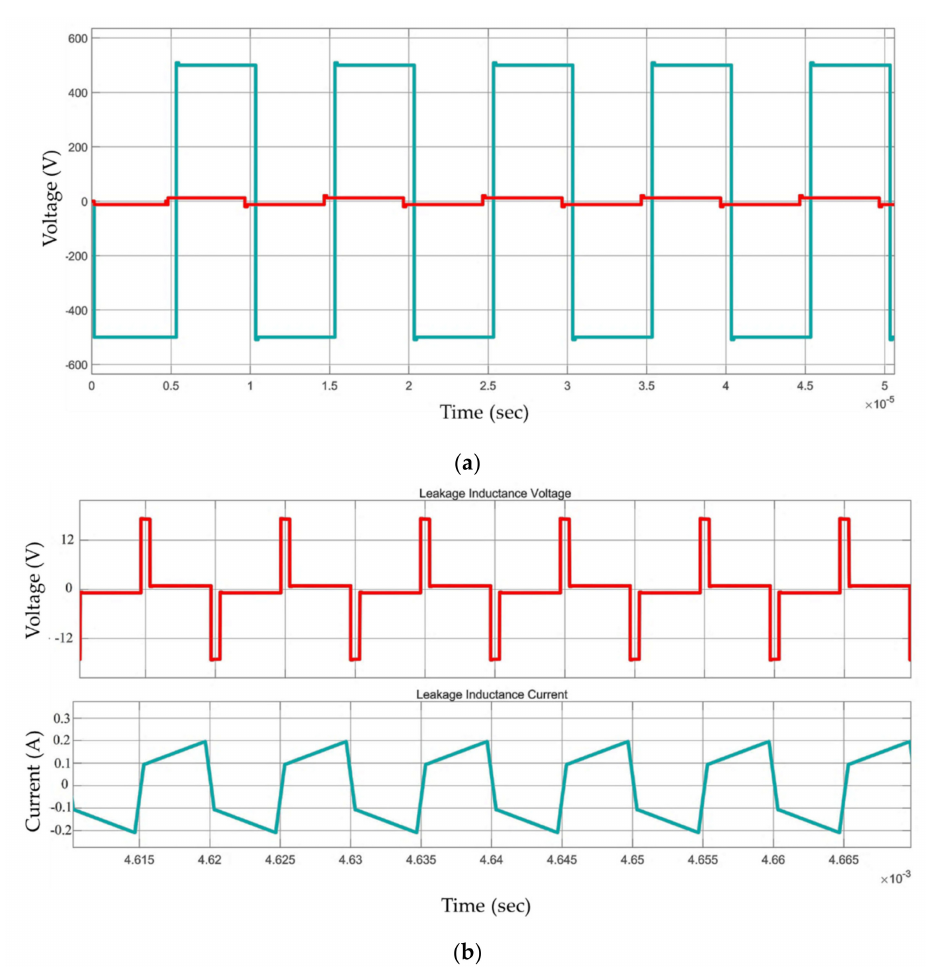
Figure 19. Transformer voltages ( a ) Primary and secondary winding ( b ) Leakage inductance voltage and